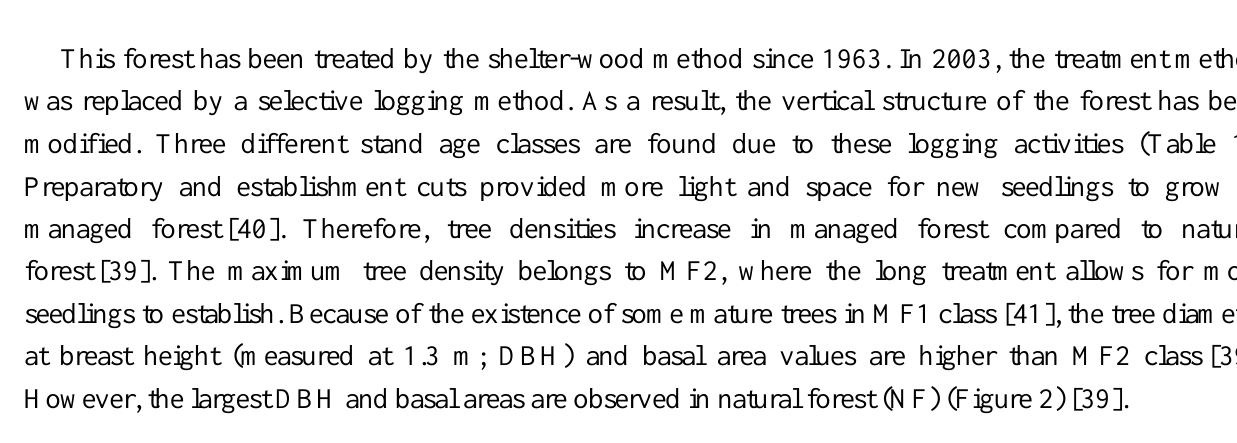
Table 1. Characteristics of three selected forest types.